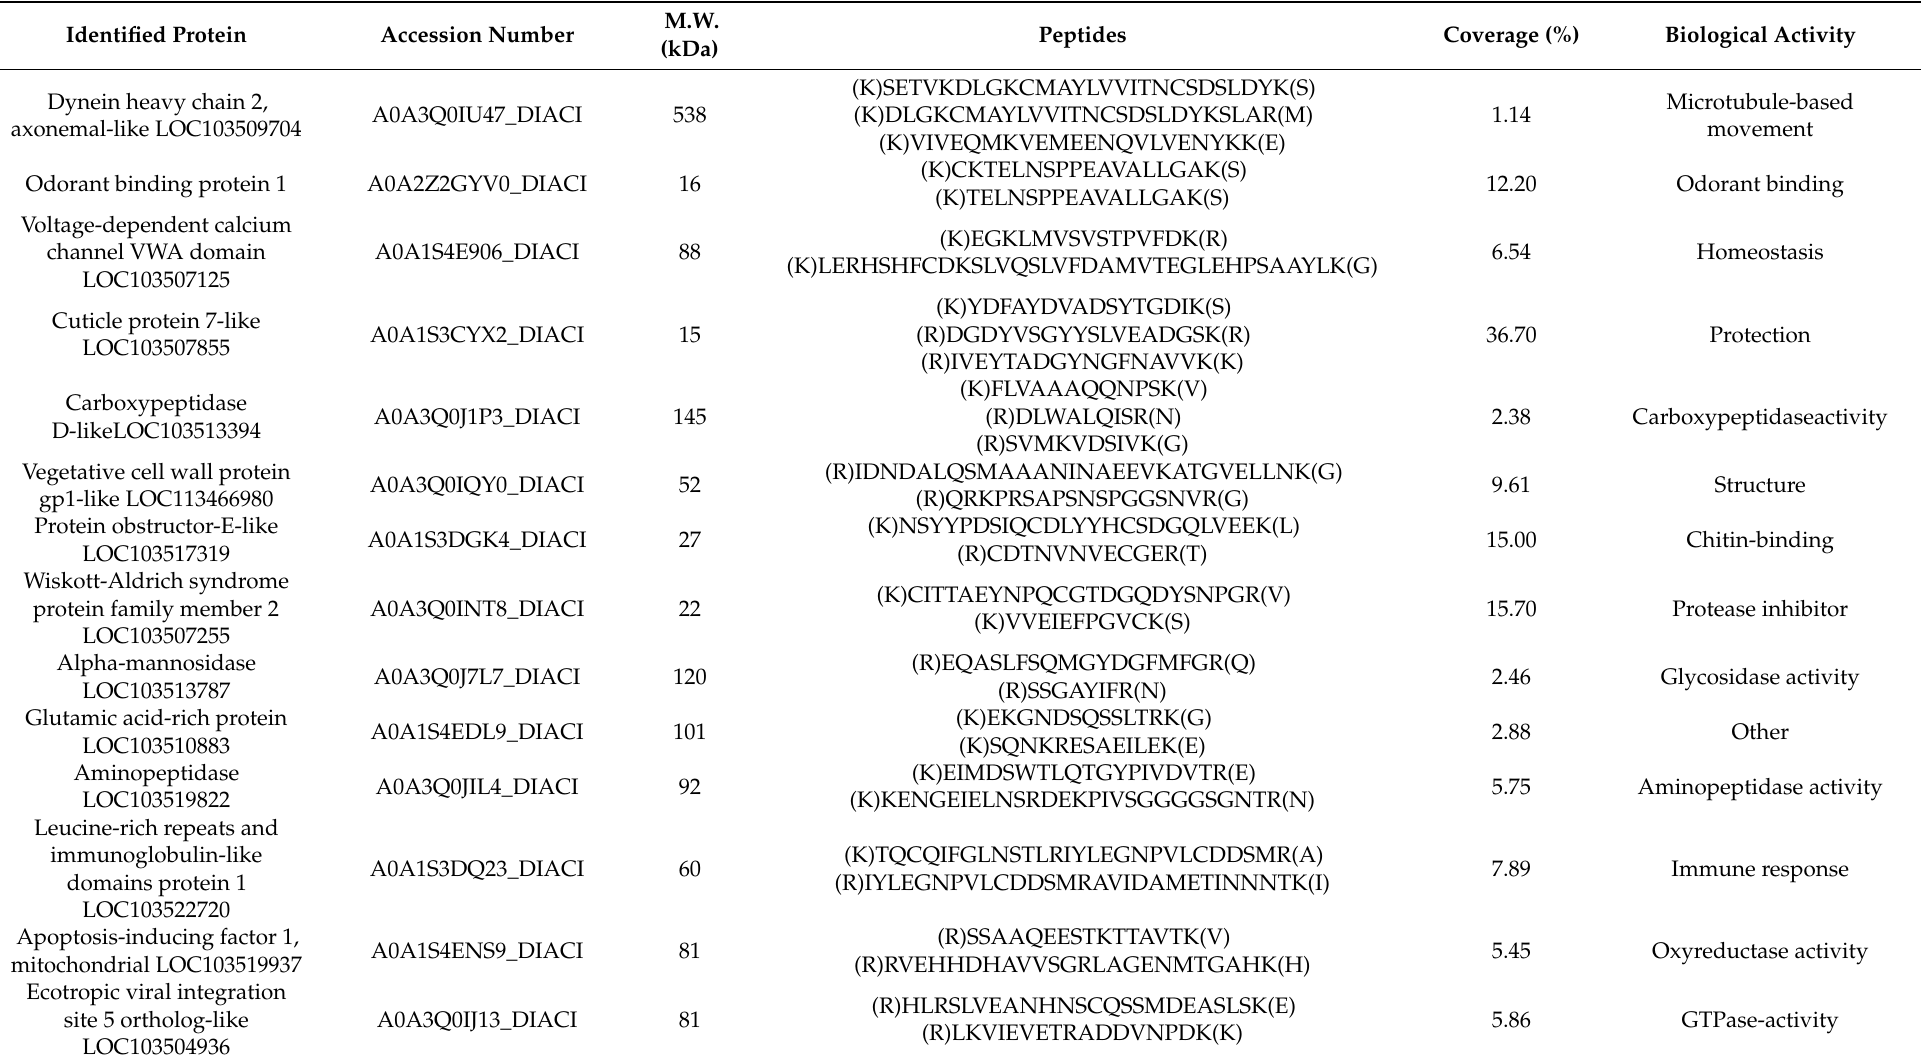
Table 1. Proteins identified from Diaphorina citri